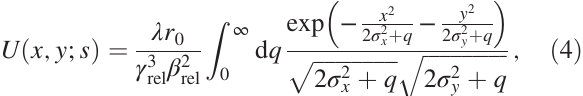
p ffiffiffiffiffiffiffiffiffiffiffiffiffiffiffiffi ffiffiffiffiffiffiffiffiffiffiffiffiffiffiffiffi þ q 2 σ 2 x